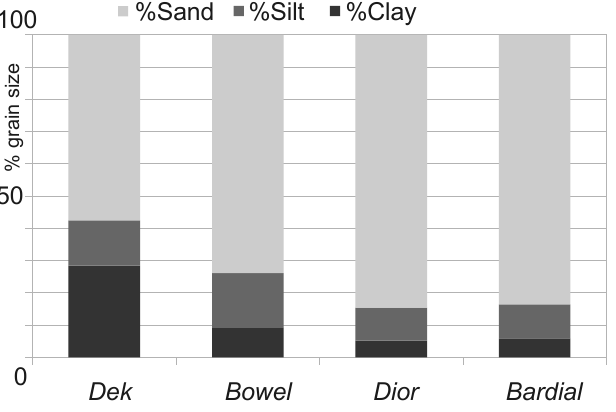
Figure 3. Grain size distribution of the 4 soil types. Note that Dior and Bardial have an almost identical